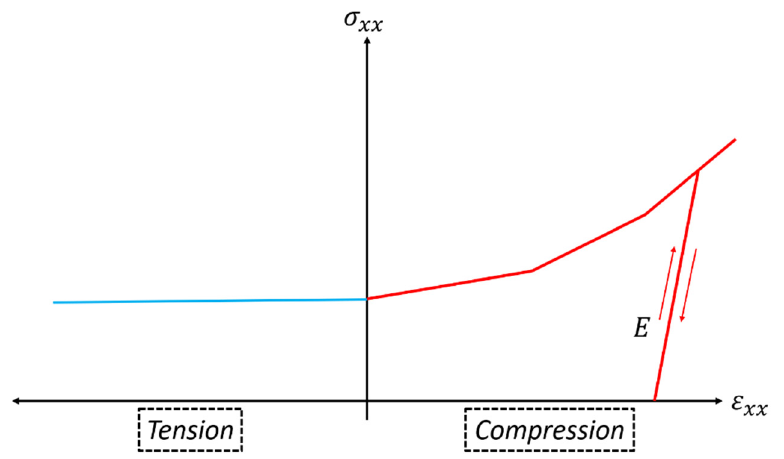
Figure 13. Load curve LS-DYNA.